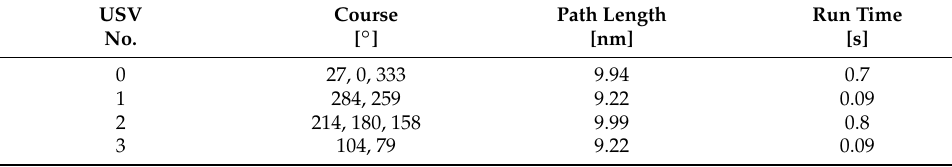
Table 13. Output data of test case